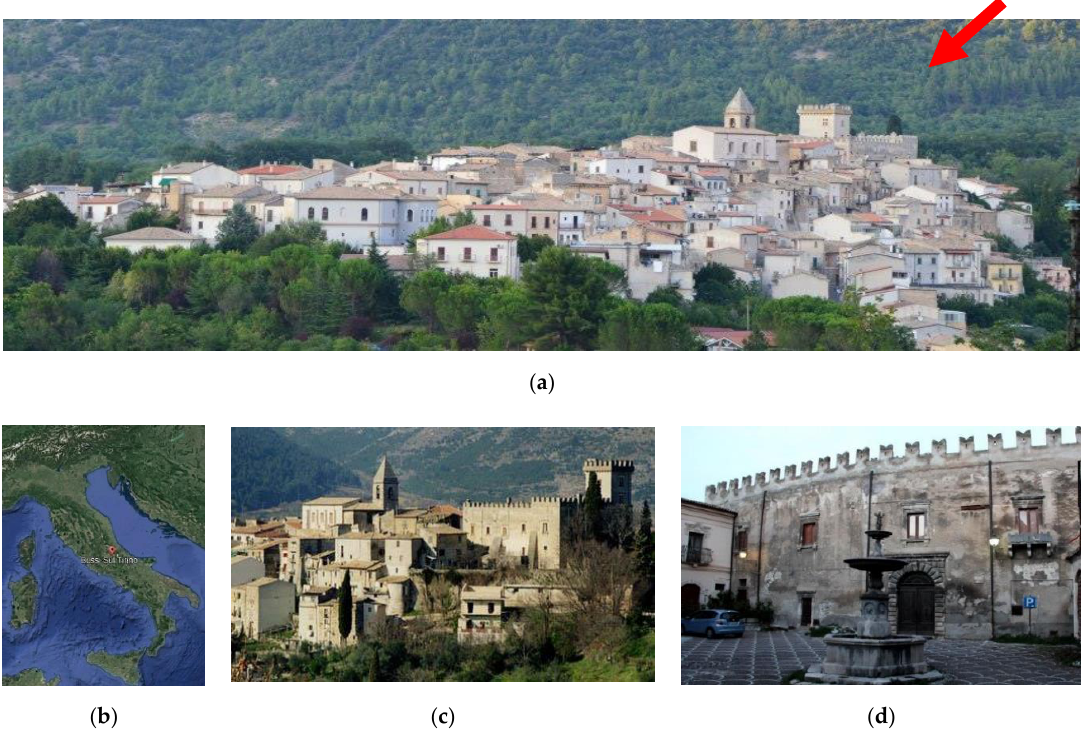
Figure 1. ( a ) The town of Bussi sul Tirino; ( b ) localization from Google Earth (42°35′37.16″N 15°08′03.05″E); ( c ) the castle; ( d ) the main façade of the castle .